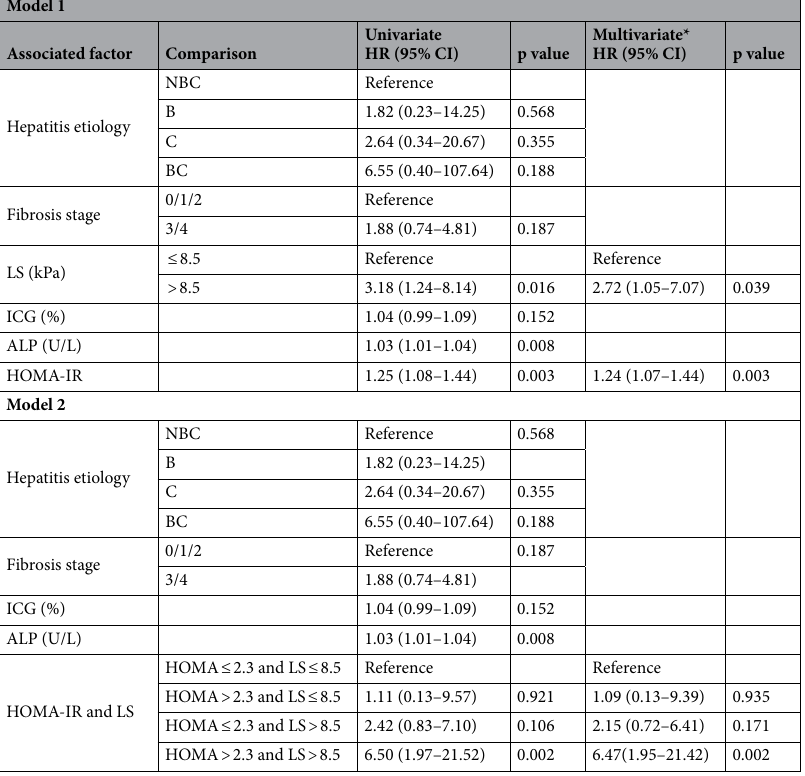
Table 3. Uni- and multi-variate analysis of factors associated with late recurrence (n = 75). B hepatitis B virus, C hepatitis C virus, NBNC non-hepatitis B virus and non-hepatitis C virus, LS liver stiffness, ICG indocyanine green, ALP alkaline phosphatase, HOMA-IR homeostatic model assessment for insulin resistance, *all characteristics in Table 1 were included in the univariable analysis and those with p values < 0.2 were entered into stepwise multivariable